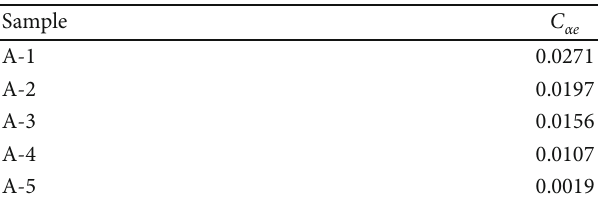
Table 2: Creep coe ffi cient of sample A-1 to A-5.